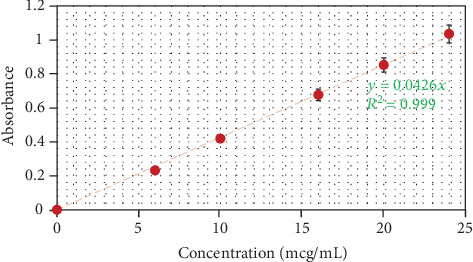
Calibration curve of CXB in methanol (mean ± SD, n = 3).